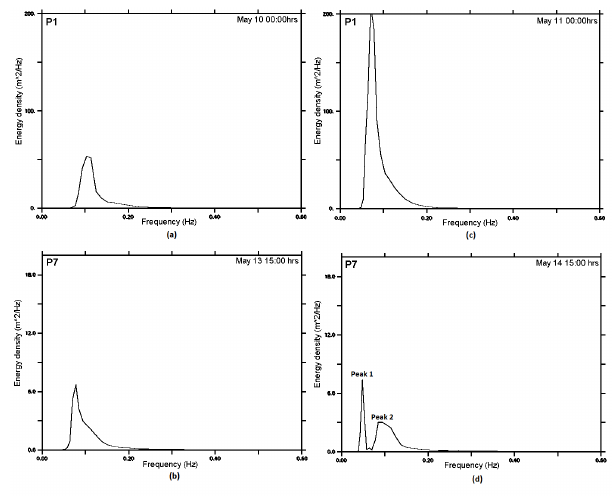
Fig. 8. Typical 2-D energy spectra at two locations P1 and P7 (a) and (b) before and (c) and (d) during the event in May 2007.